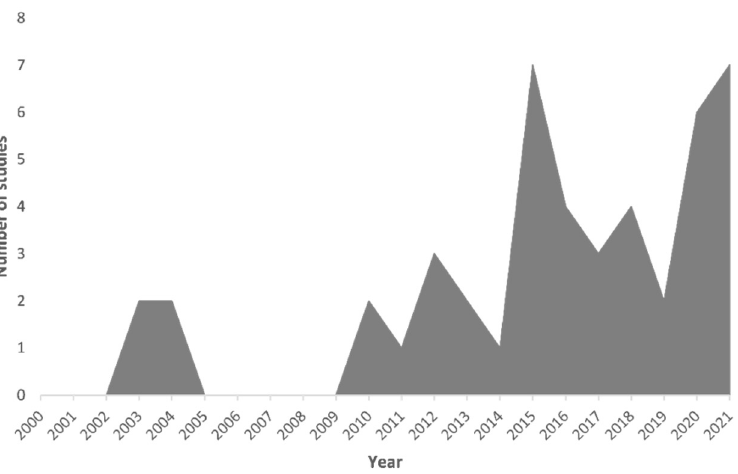
Figure 8. Timewise studies focusing on tick for Borrelia burgdorferi in the last two decades.